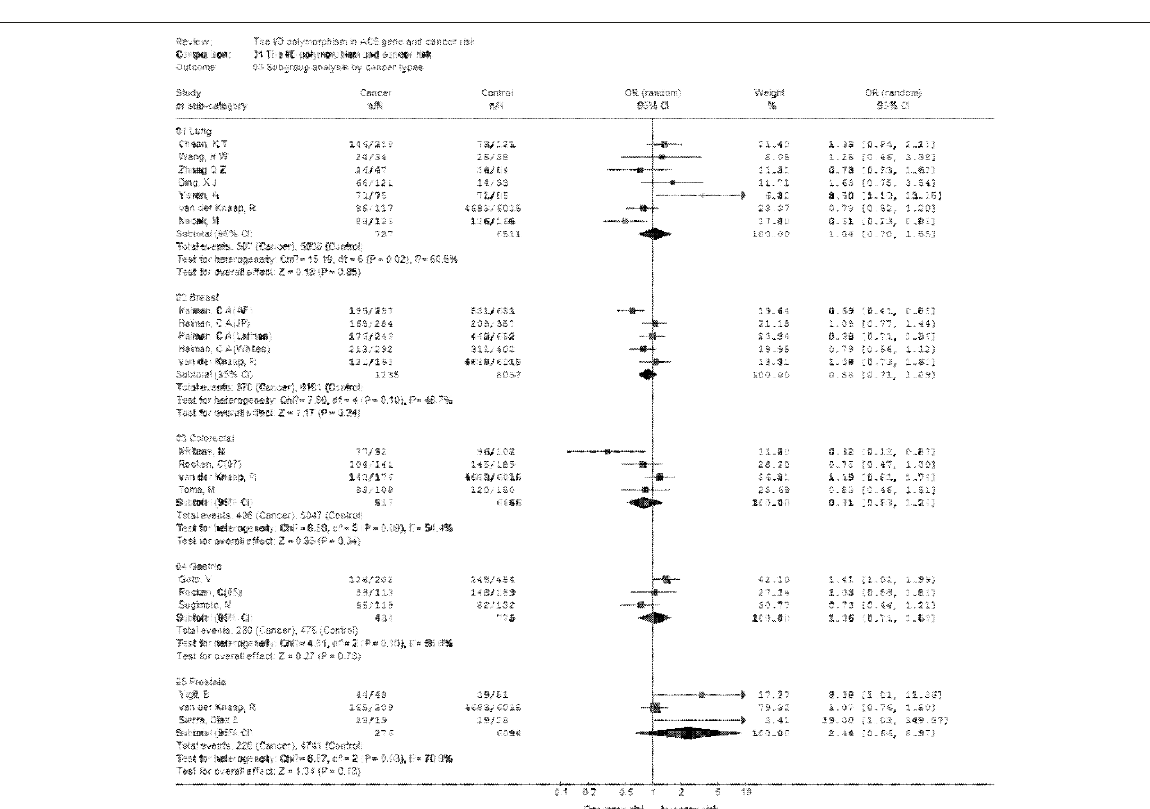
Figure 4 Meta-analysis with a random-effects model for the association between cancer risk and the ACE I/D polymorphism (DD+DI vs II): subgroup analysis by cancer type